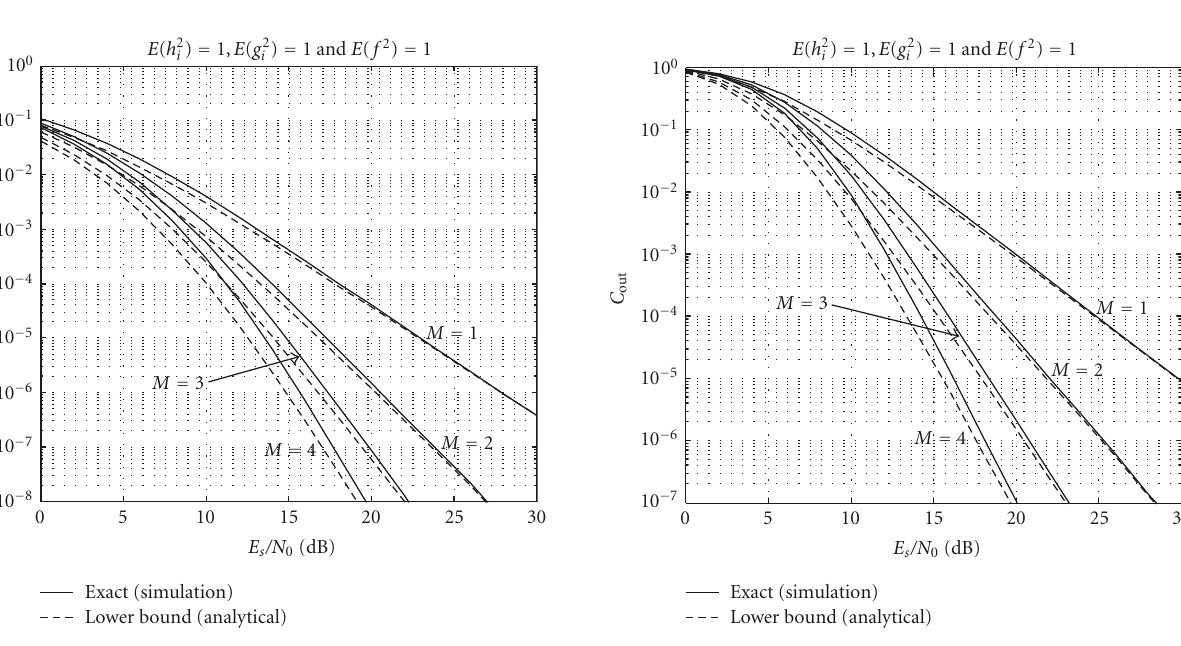
Figure 2: Error performance for the best-relay selection scheme over Rayleigh fading channels.